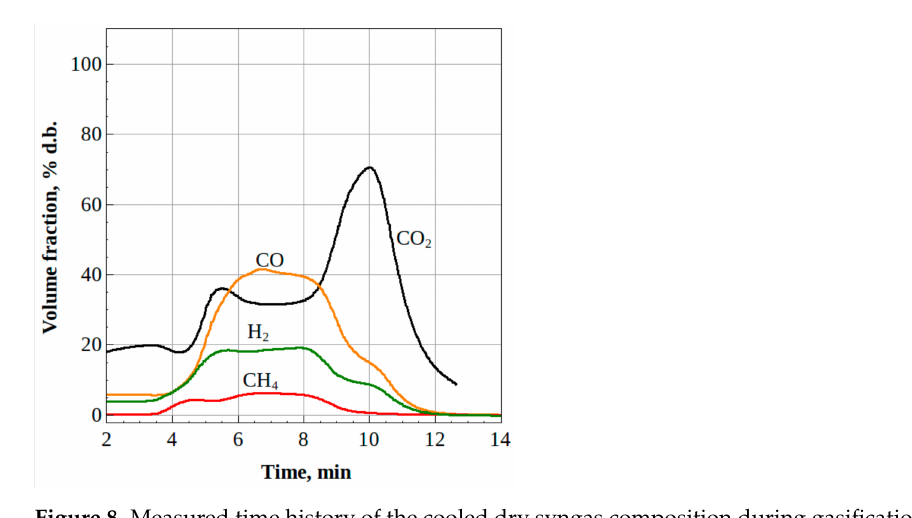
Figure 8. Measured time history of the cooled dry syngas composition during gasification of a 2-kg batch of wood sawdust at f = 1 Hz and P ≈ 0.1 MPa in a 40-dm 3 reactor.